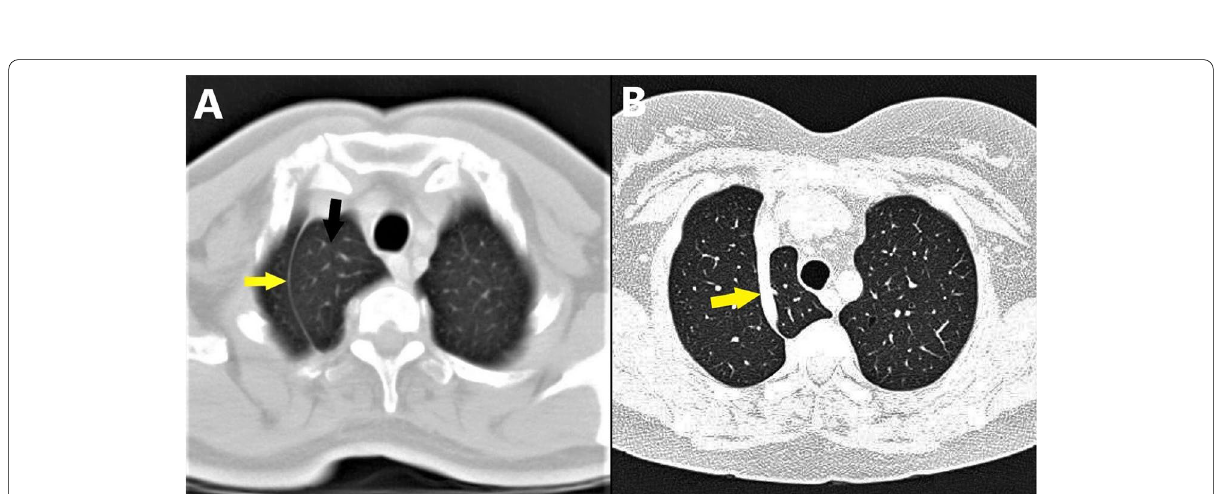
Fig. 3 a , b HRCT thorax of normal azygos lobe and fissure. a Axial HRCT thorax image demonstrates the azygos fissure as a C-shaped thin curvilinear density (yellow arrow) and the azygos lobe (black arrow) medial to it (courtesy of Dr. Ramesh Giti, MD, Mashhad University of Medical Sciences, Mashhad, Iran). b Axial HRCT thorax shows the azygos vein as a thicker band (yellow arrow) within the right upper